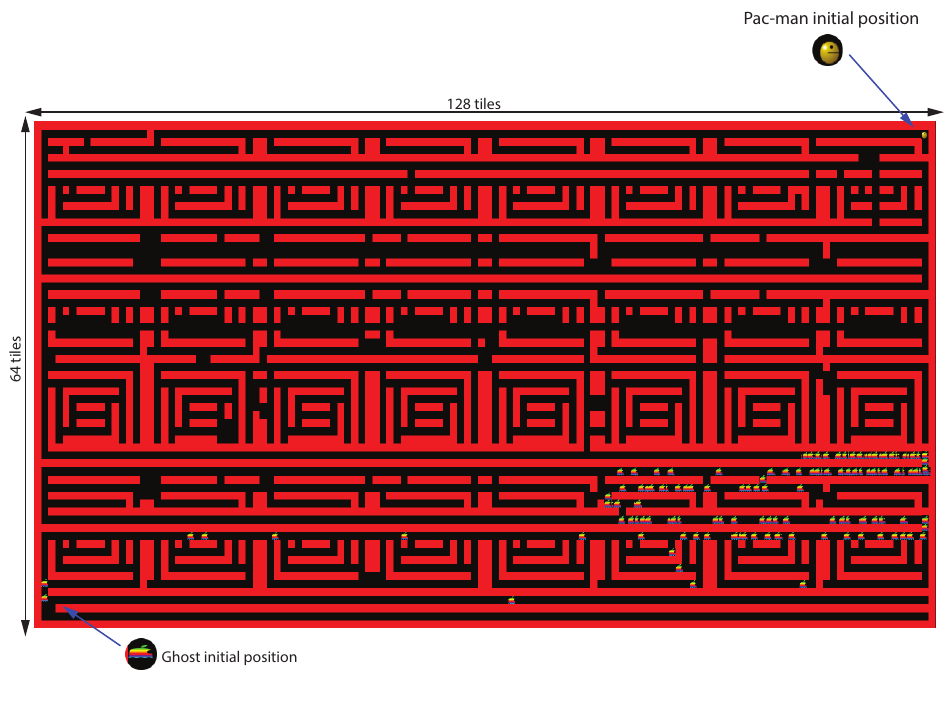
Fig. 5: 2D maze scenario.